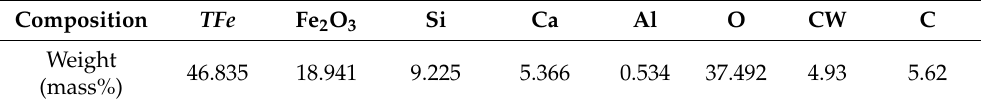
Table 1. Contexture of goethite